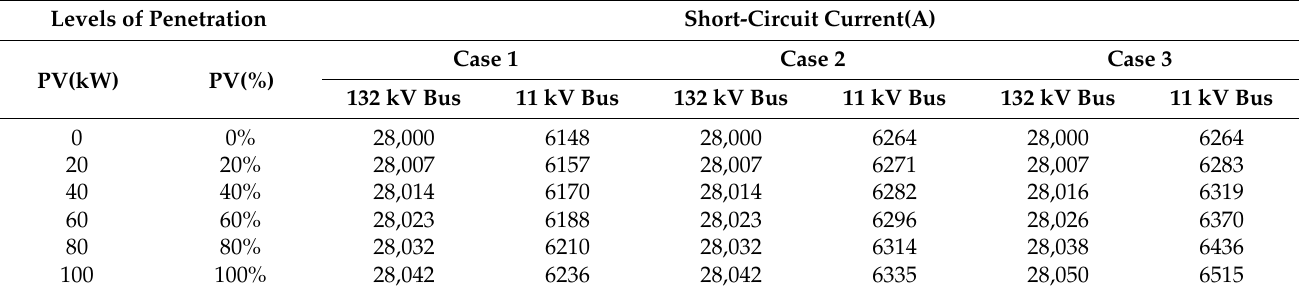
Table 3. A comparison of short-circuit currents during a period of